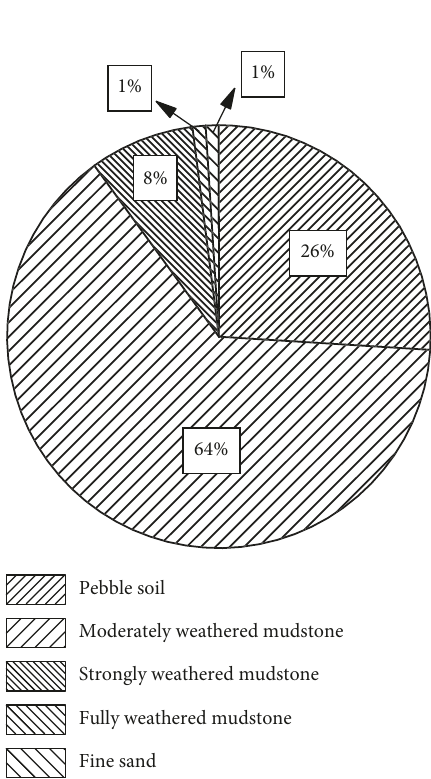
Figure 2: Geological composition of the tunnels in the TS-ES section.